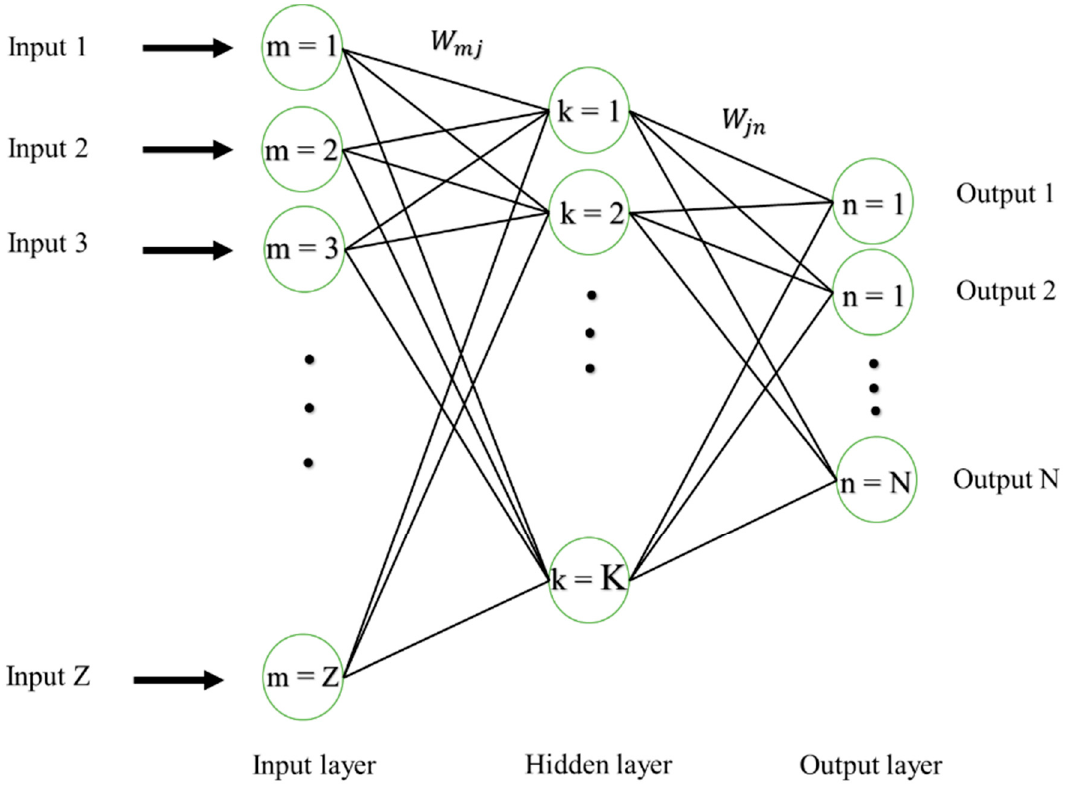
Figure 1. The general structure of the multi-layer perceptron (MLP) network.